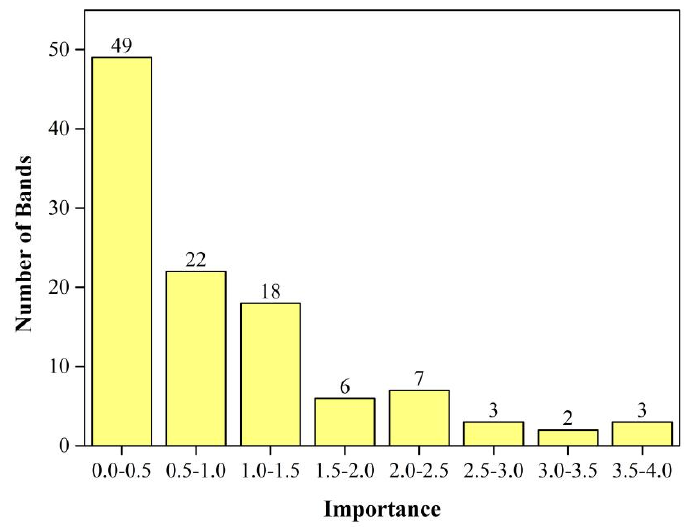
Figure 6. The number of bands for each scored segment. Table 3. The information of different multi-temporal